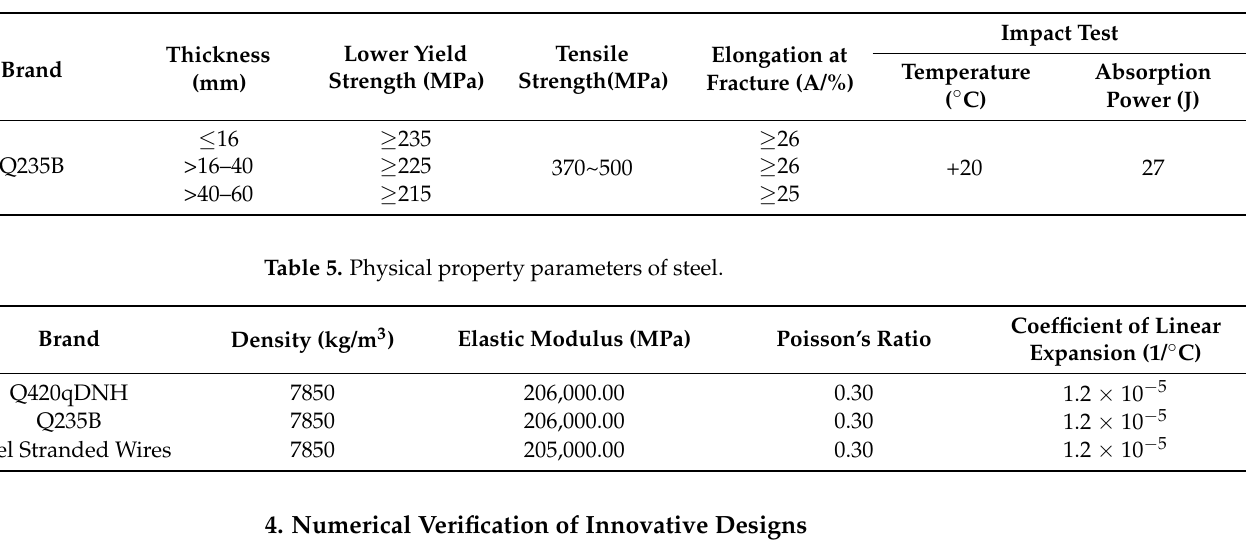
Table 4. Mechanical property parameters of steel for auxiliary structures.